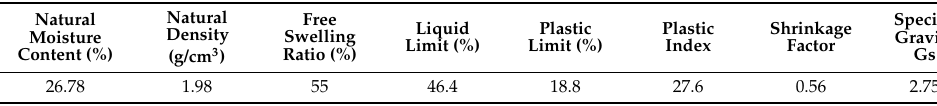
Table 1. Basic physical properties of expansive soil samples.